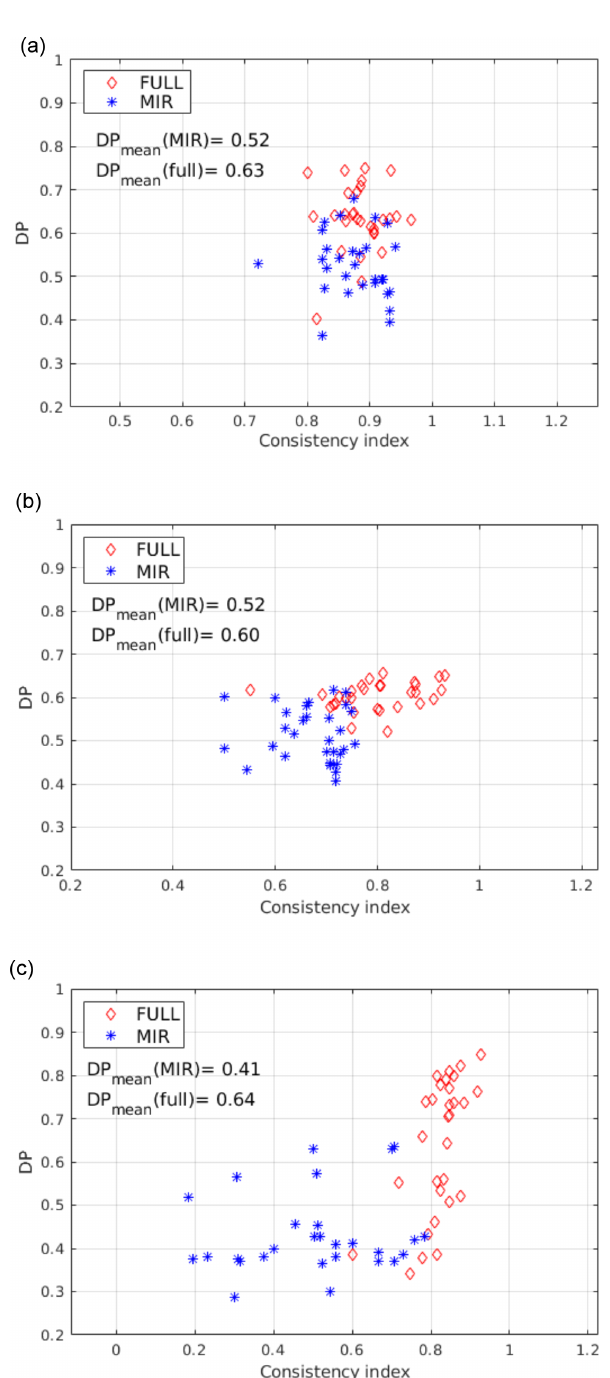
Figure 13. Clear and cloudy classification DP using the distribu- tional approach for the MIDWIN case (a) , the POLWIN case (b) and POLSUM (c) . Data are plotted as function of CoI, and 60 TraNC are used for each